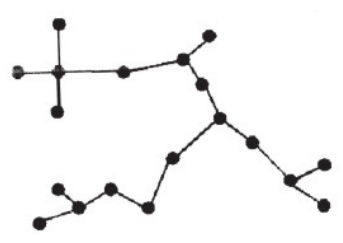
Figure 4. Example of a Minimum Spanning